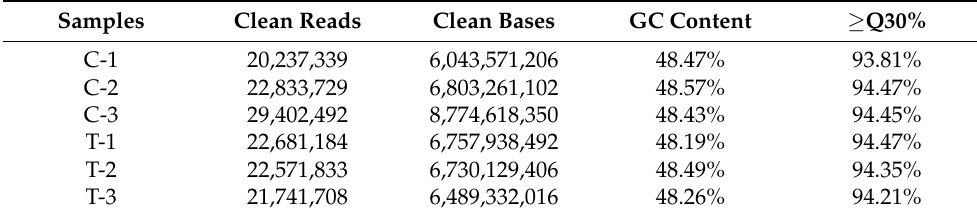
Table 2. Sequencing data statistics.